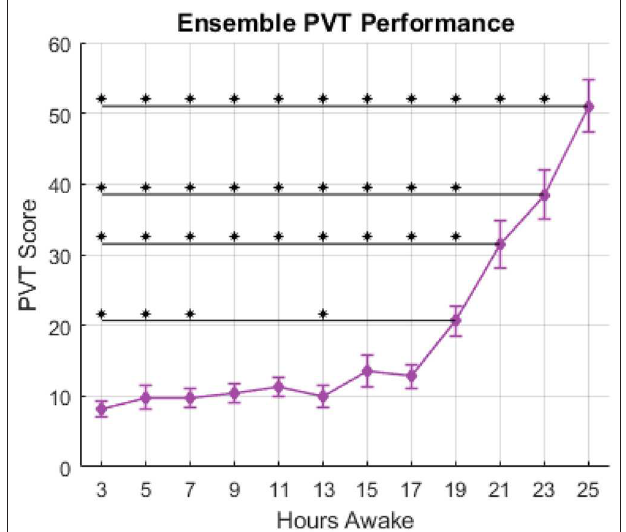
FIGURE 1 | PVT score vs. hours awake, ensemble-averaged across subjects. Error bars indicate standard error in a given session. Asterisks above horizontal lines indicate significant differences ( p < 0.05) between sessions as determined by the Tukey-Kramer post-hoc multiple comparisons